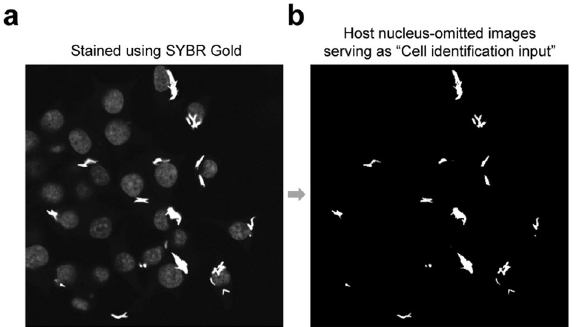
Figure 1. Staining by SG dye of RAW264.7 cells infected with M. bovis BCG ( a ), and the omission of stained host cell nuclei ( b ). Host cell nuclei were empirically omitted in ImageJ following the procedure: Image > Adjust > Brightness/Contrast… > Set > type proper ‘minimum displayed value’ (150 for b ) >